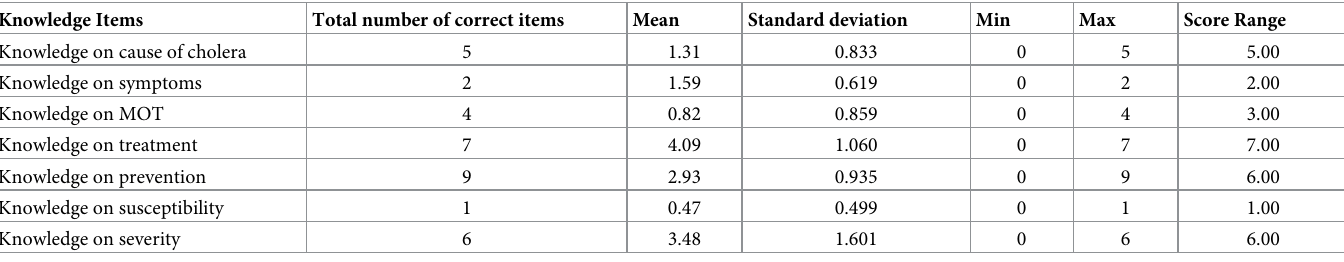
Table 4. Summary of knowledge scores among respondents in Addis Ketema sub-city, Addis Ababa, Ethiopia, 2020. Knowledge